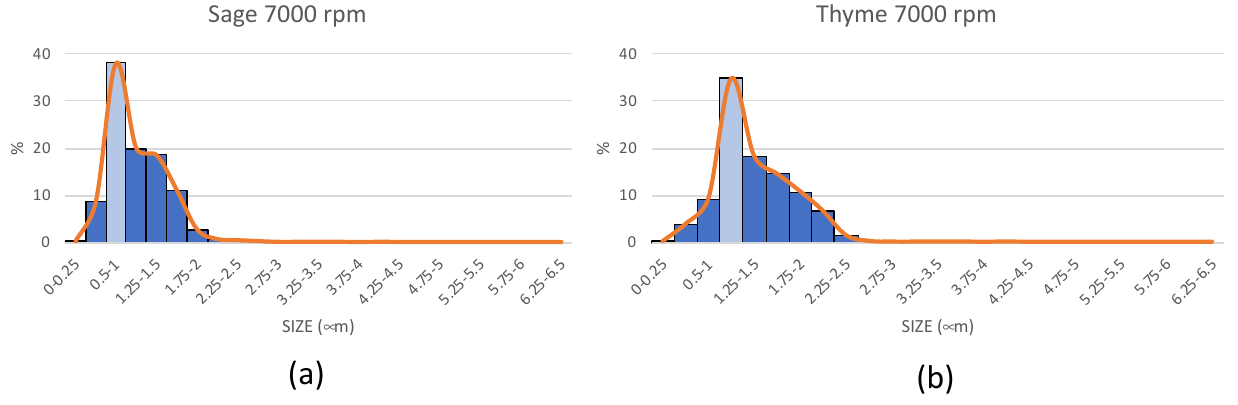
Figure 3. Size distribution of sage and thyme 4% emulsions on PVA solution. ( a ) Sage; ( b )